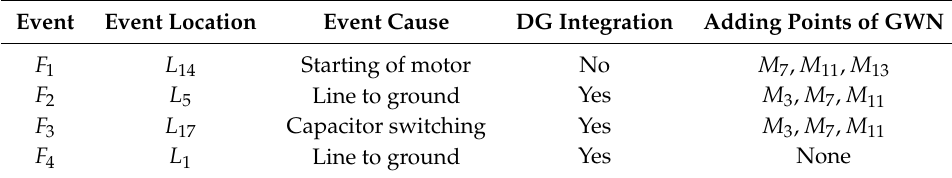
Table 1. Description of different transient voltage disturbance